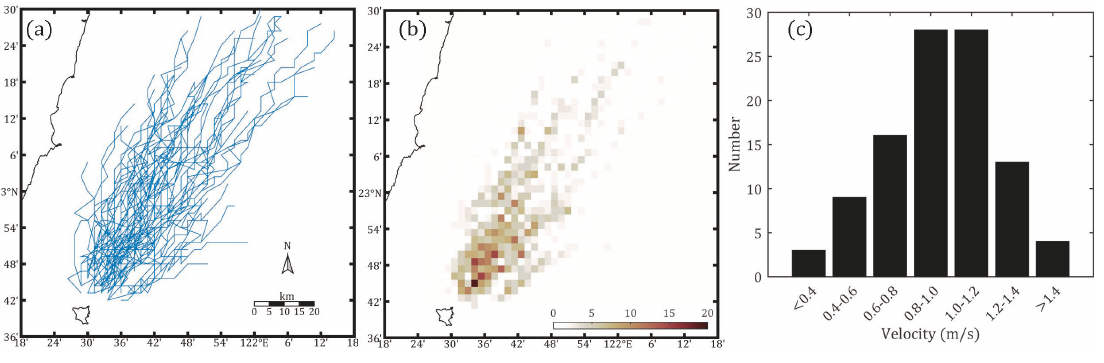
Figure 10. ( a ) trajectory of 101 vortex cases, ( b ) the distribution probability (%) of the vortices for 101 cases, and ( c ) a histogram of the property speed statistics for 101 vortex cases.